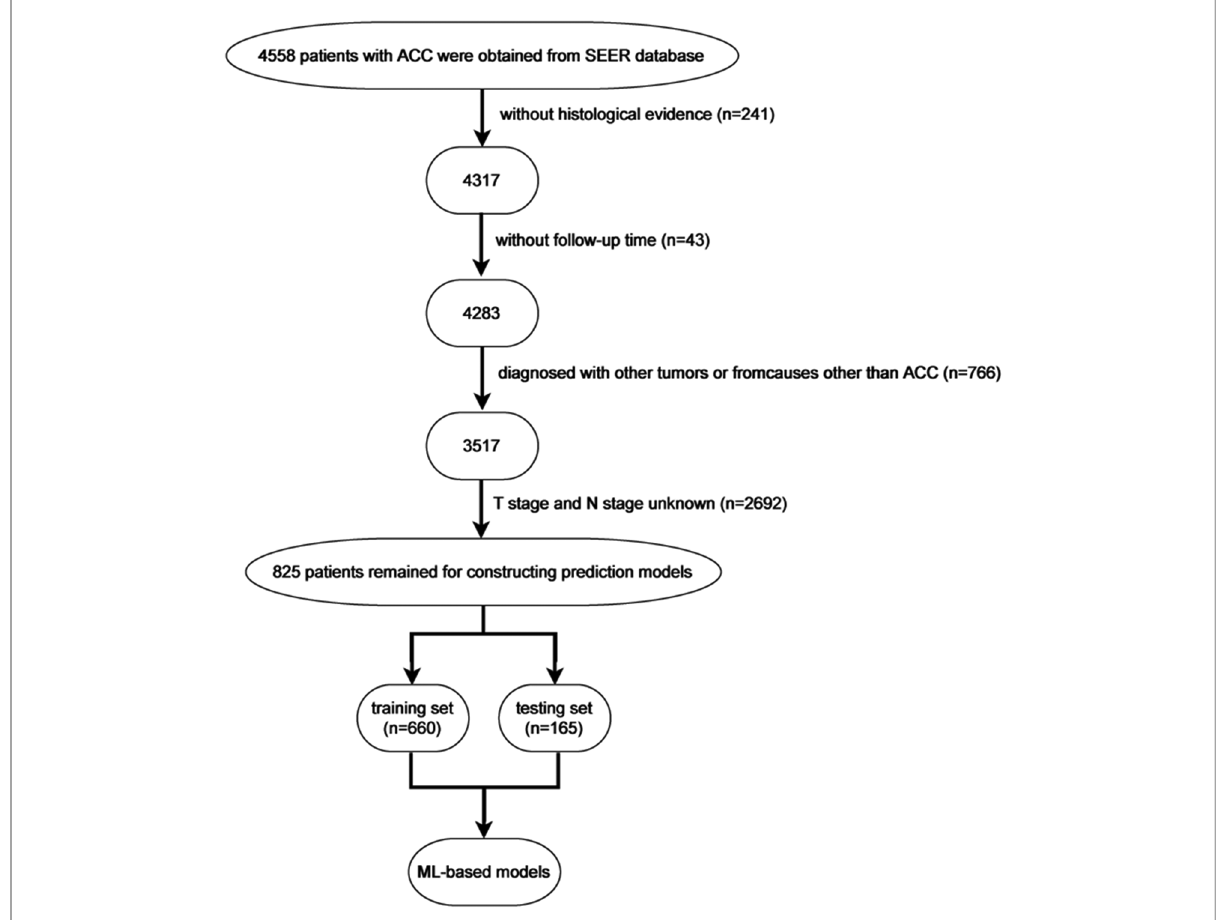
FIGURE 1 Flow chart showing the exclusion process of patients with ACC from the Surveillance, Epidemiology, and End Results (SEER) program database and internal and external